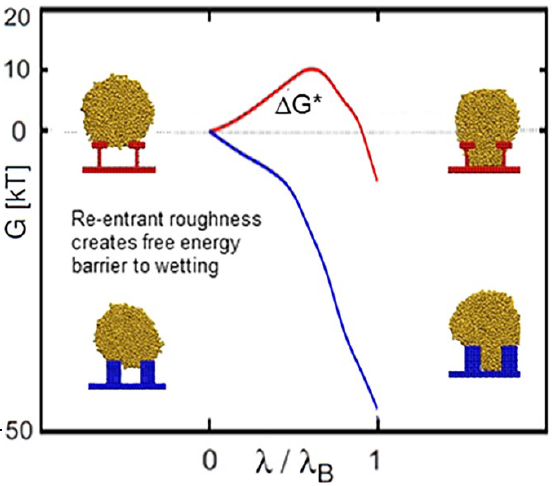
Figure 8. Re-entrant roughness creates a higher energy barrier to wetting. Reprinted with permission from Ref. [108]. Copyright@2012, Langmuir.